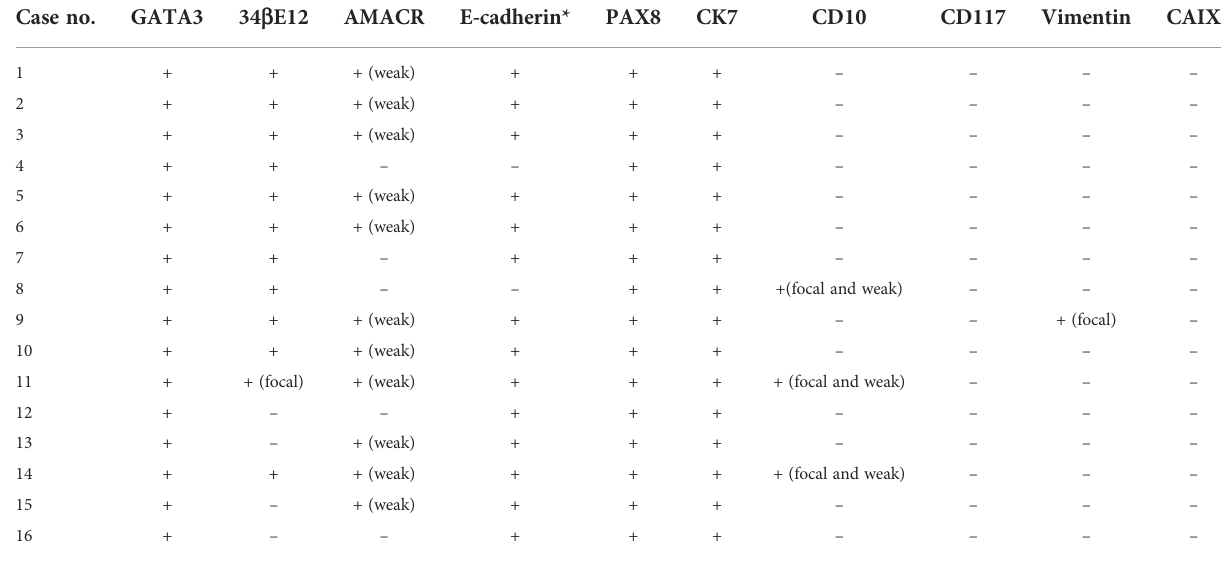
TABLE 2 Immunohistochemistry staining features of PRNRP. Case